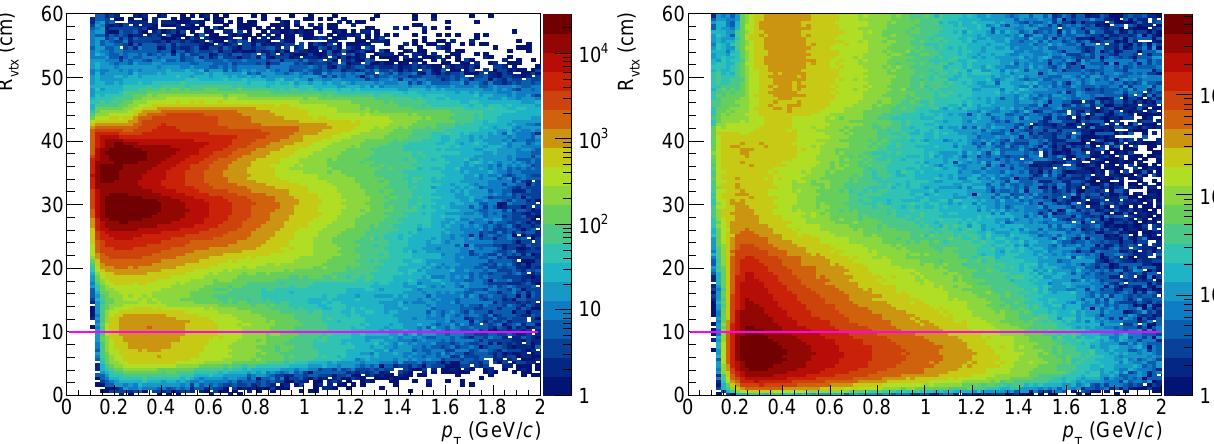
Figure 4. Distributions of signal ( left ) and background ( right ) pairs as a function of radial position of the vertex and transverse momentum of the reconstucted pair. Selection limits are shown with magenta